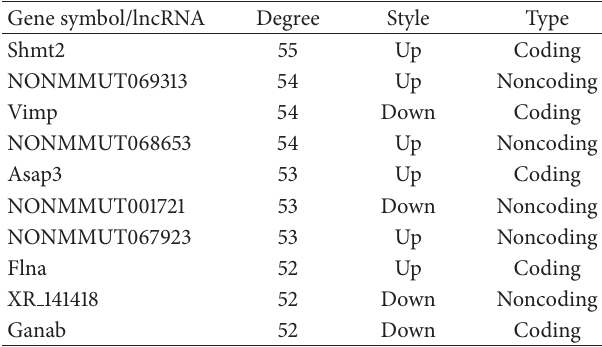
Table 2: Part of lncRNAs and mRNAs owned the biggest degree in control group.